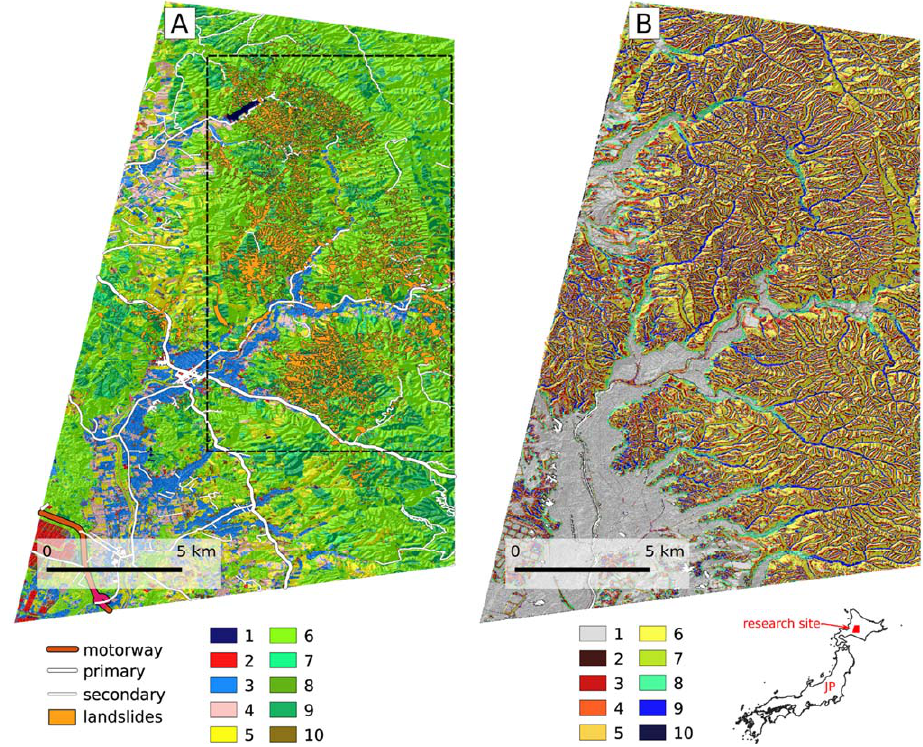
Figure 1. Land use and land cover ( A ) and terrain forms ( B ) of the study site. Legend ( A ): 1 = water; 2 = urban and built ‐ up; 3 = rice paddy; 4 = crops; 5 = grassland; 6 = deciduous broadleaf forest; 7 = deciduous needle ‐ leaf forest; 8 = evergreen broadleaf forest; 9 = evergreen needle ‐ leaf forest; 10 = bare land (data source: HRLULC ver. 16.09 [82]). Dashed line on Figure A indicates the extent of the closer study area. Legend ( B ): 1 = flat; 2 = summit; 3 = ridge; 4 = shoulder; 5 = spur; 6 = slope; 7 = hollow; 8 = footslope; 9 = valley; 10 = depression. Terrain forms were calculated using the r.geomeor ‐